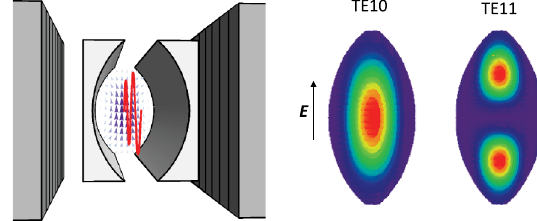
FIG. 1. TE10 and TE11 y-component of the electric field for a curved parallel plate waveguide. The TE10 mode is the one that has the largest FEL coupling to extract energy from a relativistic electron